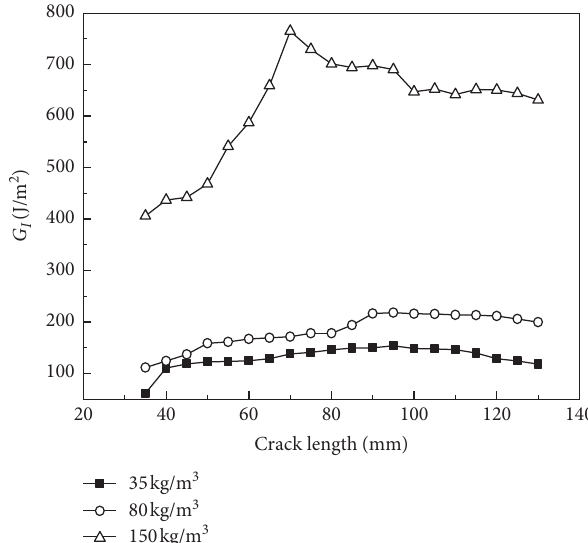
Figure 10: Strain energy release rate of specimens under different foam core